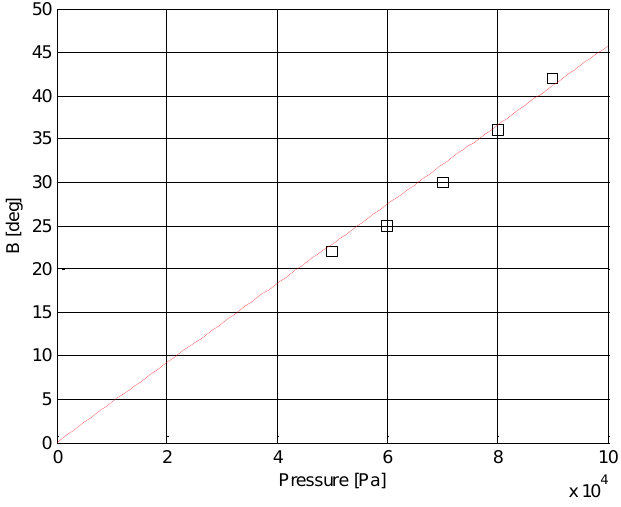
Figure 6. Static pressure response of prototype 2. Black squares mark the experiment, while red line represents the linear theory.